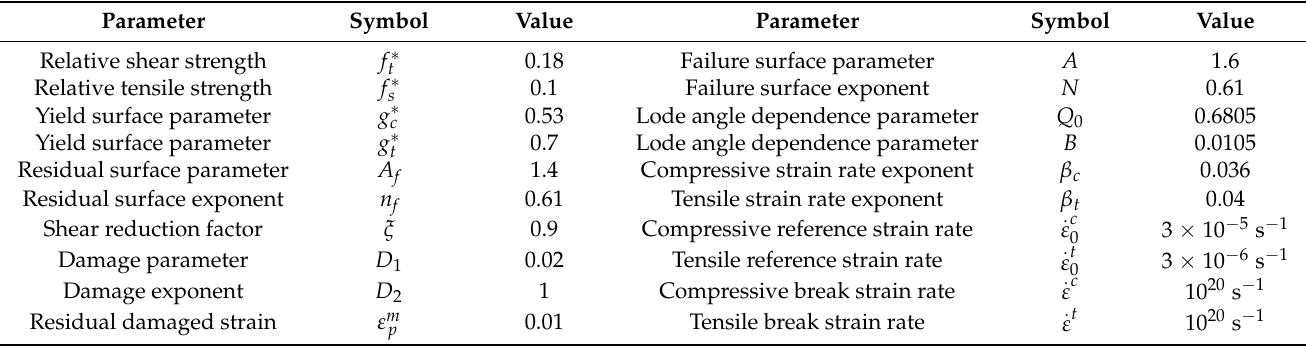
Table 5. RHT model parameters of concrete